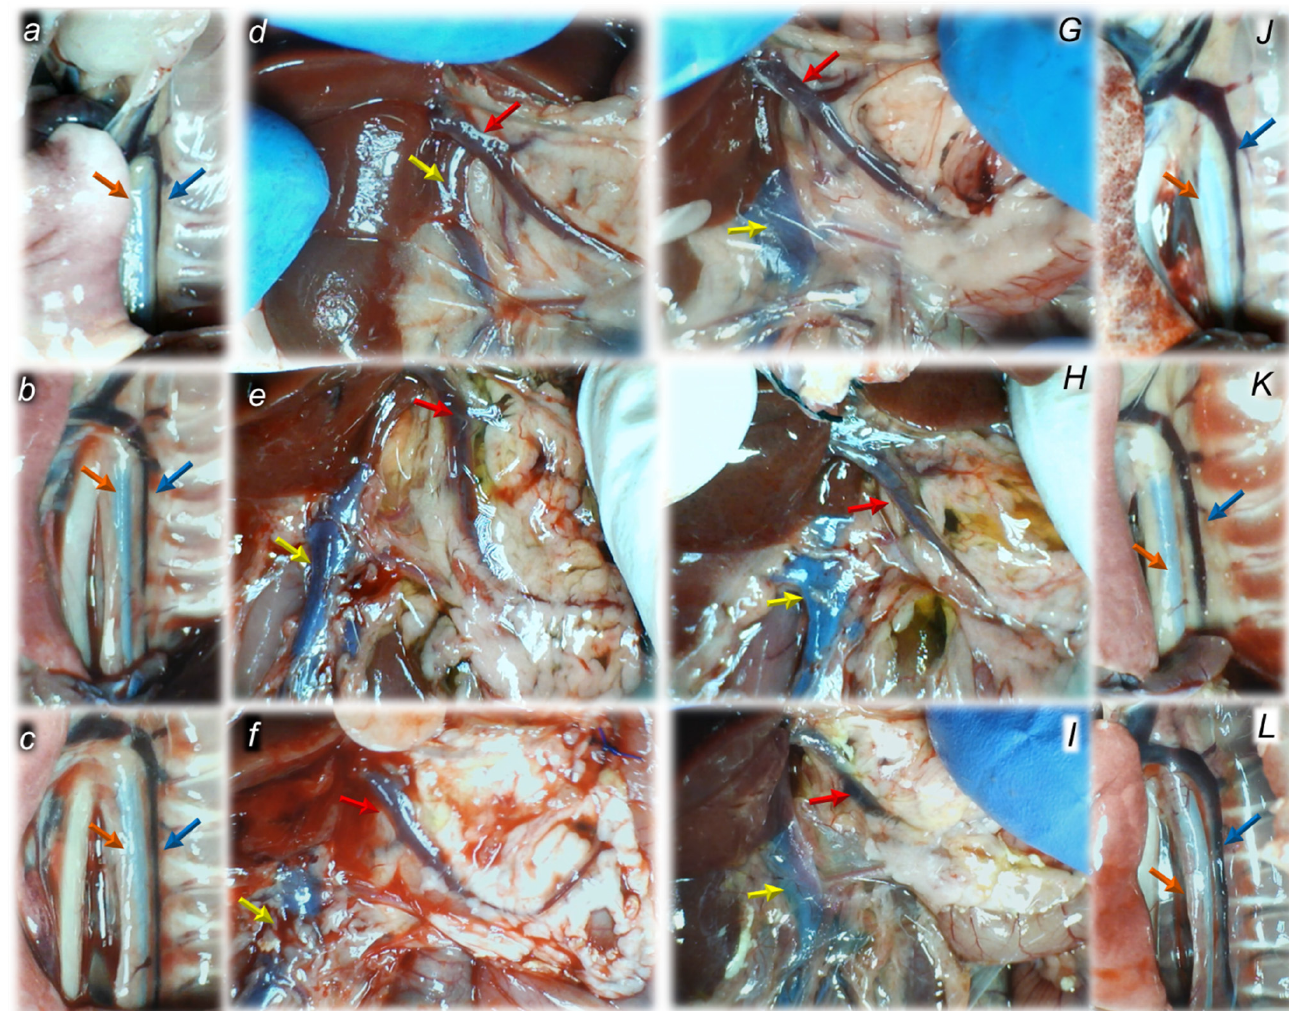
Figure 3. Regular timeline (30 min ( a , d ), 5 h ( b , e ) and 24 h ( c , f ) ligation time period) of disturbed vessels’ presentation, failed azygos vein (blue arrows) and thoracic aorta (orange arrows) ( a – c ), and congested superior mesenteric vein (red arrows) and inferior caval vein (yellow arrows) ( d – f ) in control rats with ligated bile duct. Upon BPC 157 therapy and recruitment of the defensive pathways, congestion of the superior mesenteric vein and inferior caval vein ( G – I ) and failure of the azygos vein and thoracic aorta timeline ( J – L ) was counteracted at 30 min ( G , J ), 5 h ( H , K ) and 24 h ( I , L ) ligation time period. Illustrative presentation included BPC 157 (10 ng/kg) or saline (5 mL/kg) as an intragastric administration immediately following ligation, as an early regimen. A similar presentation also included the effect of the delayed regimen.